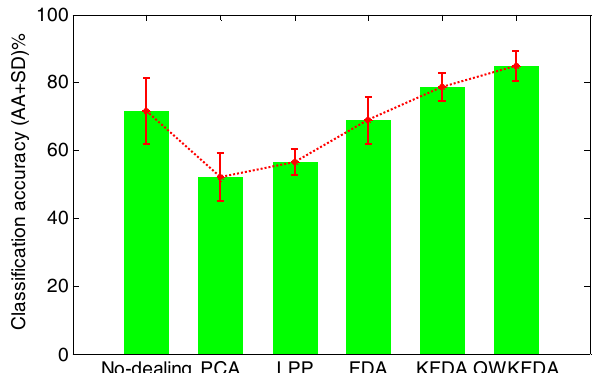
Figure 6. Classification accuracy of different feature extraction methods.